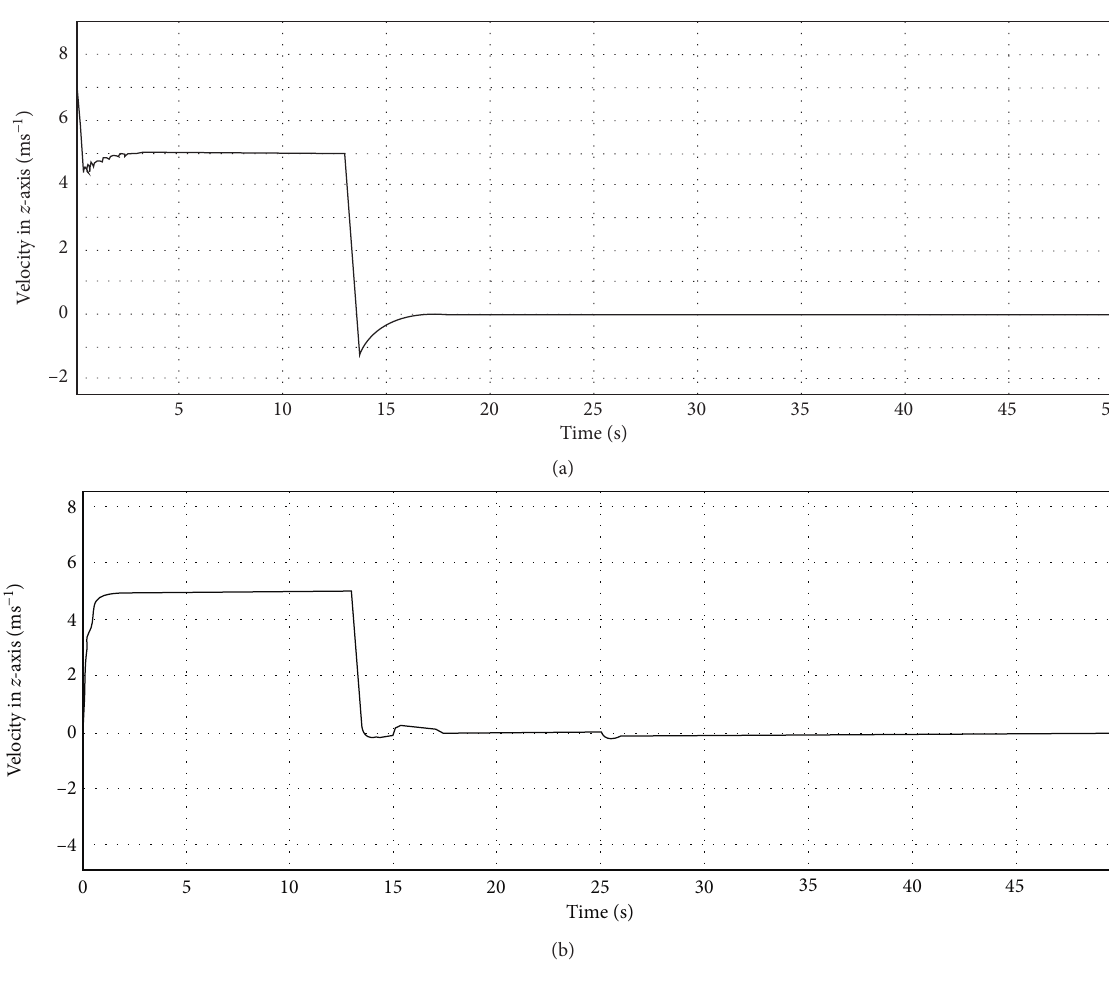
Figure 8: Z-velocity response curve. (a) PID controller. (b) Compound